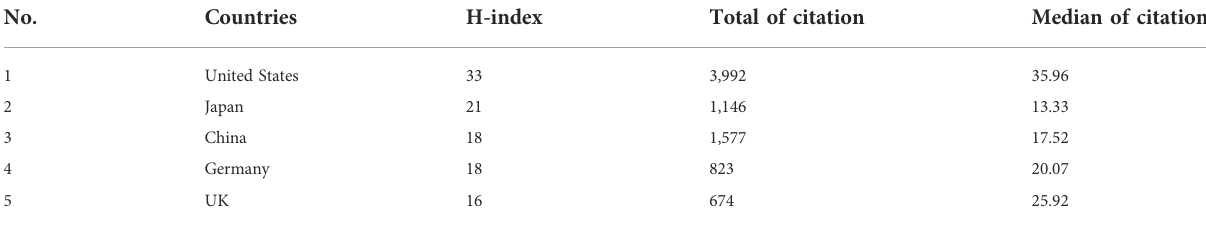
TABLE 4 Citation (all, median) and H-index of hif-phi research in top 5 countries. No. Countries H-index Total of citation Median of citation